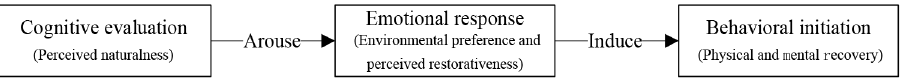
Figure 8. The process of human recovery from landscape space. This figure was created by Rui